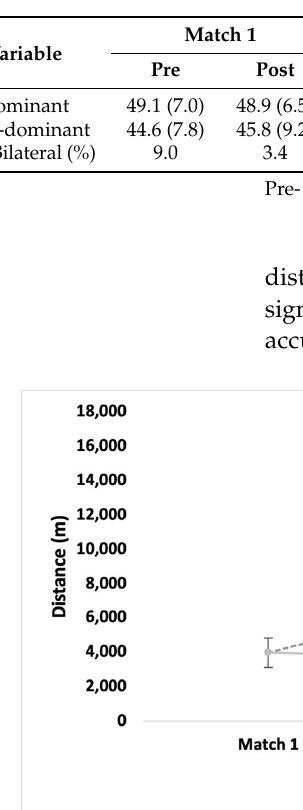
Table 2. Descriptive analysis of handgrip strength of dominant and non-dominant hand in successive WT matches.